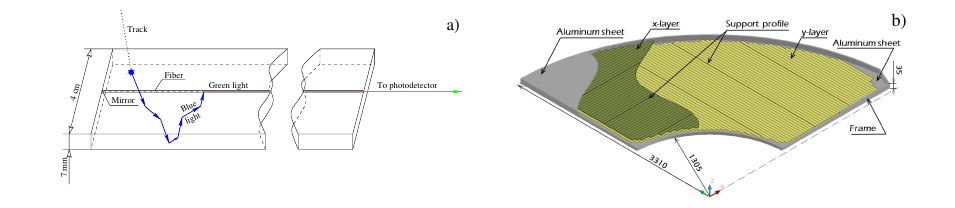
Figure 2. a) Construction of the scintillating strip with glued WLS fiber. b) Module